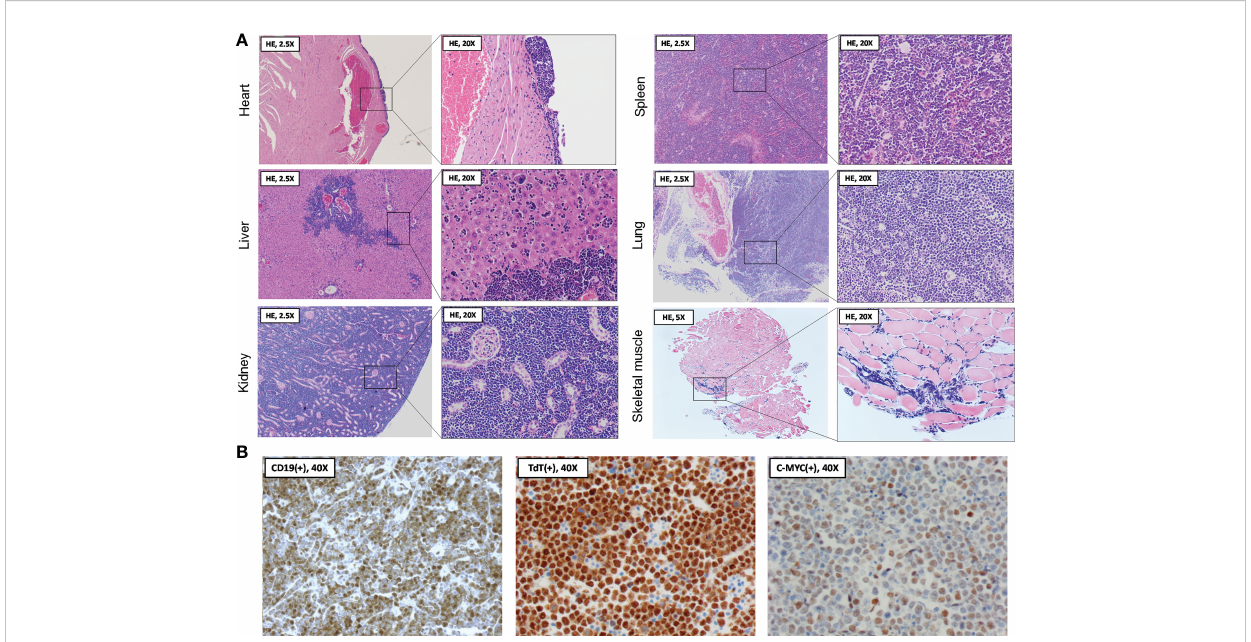
FIGURE 3 Histopathological and immunohistochemical analysis of organs following spontaneous death. (A) At necropsy two days following BNT162b2 booster, heart, liver, kidneys, spleen, lungs, and skeletal muscle were collected and processed for hematoxylin and eosin (HE) staining. Histopathological examination of the organ sections revealed a diffuse and extensive in fi ltration by medium-sized atypical cells, often completely obliterating the normal parenchyma. The skeletal muscle section showed evidence of systemic leukocytosis without parenchymal abnormalities. (B) Immunohistochemical fi ndings showing staining of medium-sized atypical cells positive for B-cell marker CD19 (left panel), with further nuclear staining positive for terminal deoxynucleotidyl transferase (TdT) (middle panel) and the c-MYC oncoprotein (right panel). Stainings are compatible with a B-cell lymphoblastic lymphoma (B-LBL)